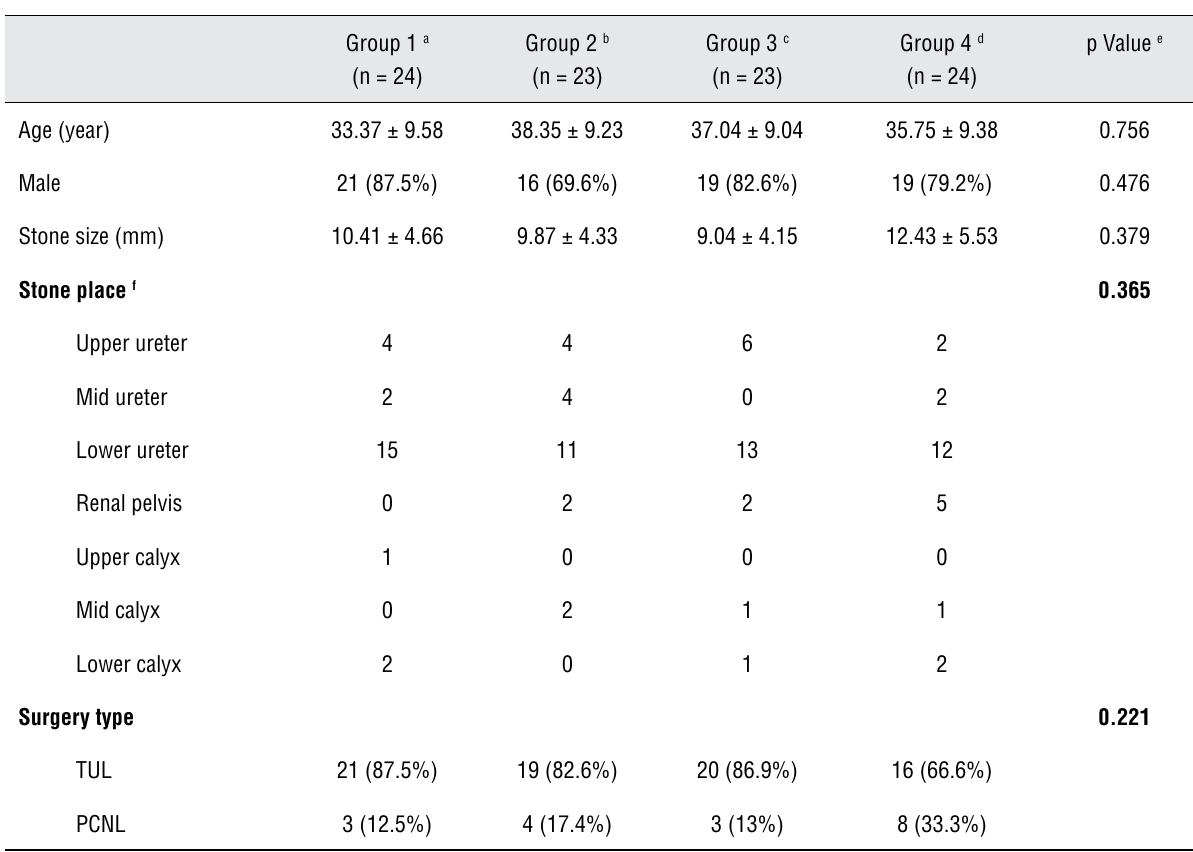
Table 1 - Basic and clinical